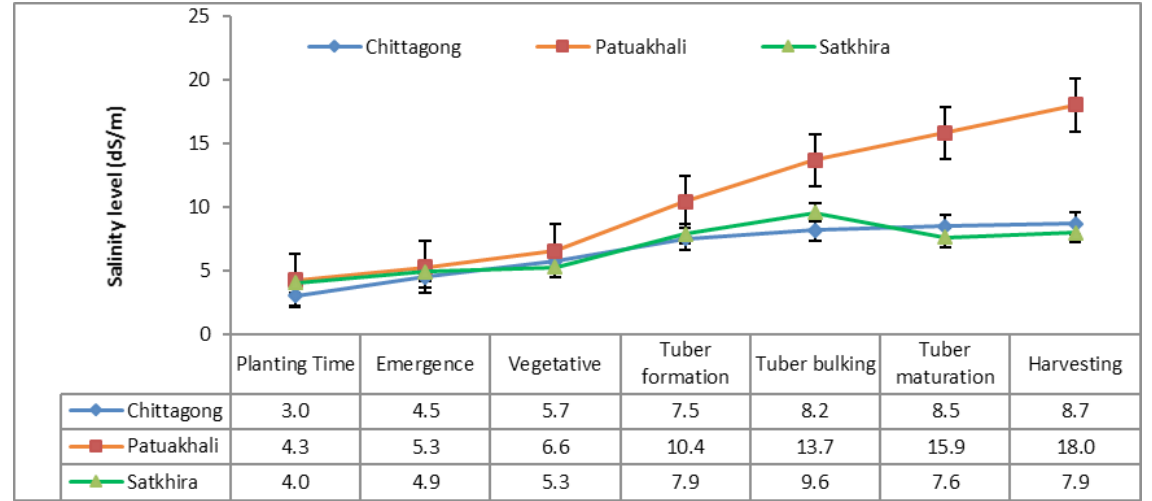
Figure 1: Salinity level of salt tolerance trial during different growth to harvest stages of potatoes at Chittagong, Patuakhali & Satkhira during 2011 to 14 crop seasons